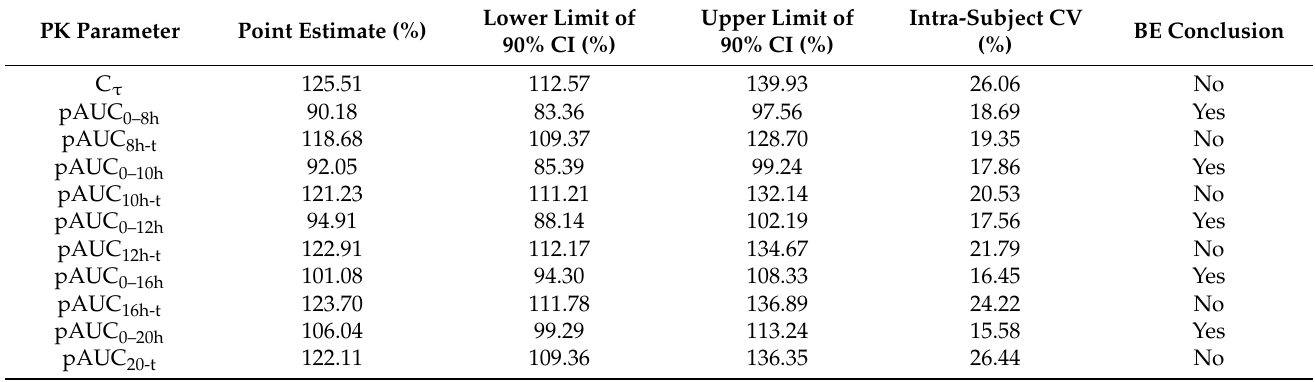
Table 1. Bioequivalence evaluation of desvenlafaxine 100 mg prolonged-release tablets after a single dose under fasting conditions in 32 healthy volunteers.